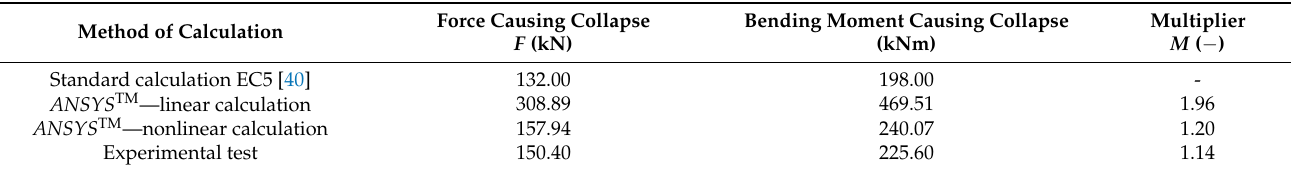
Table 7. Comparison of results of individual computational